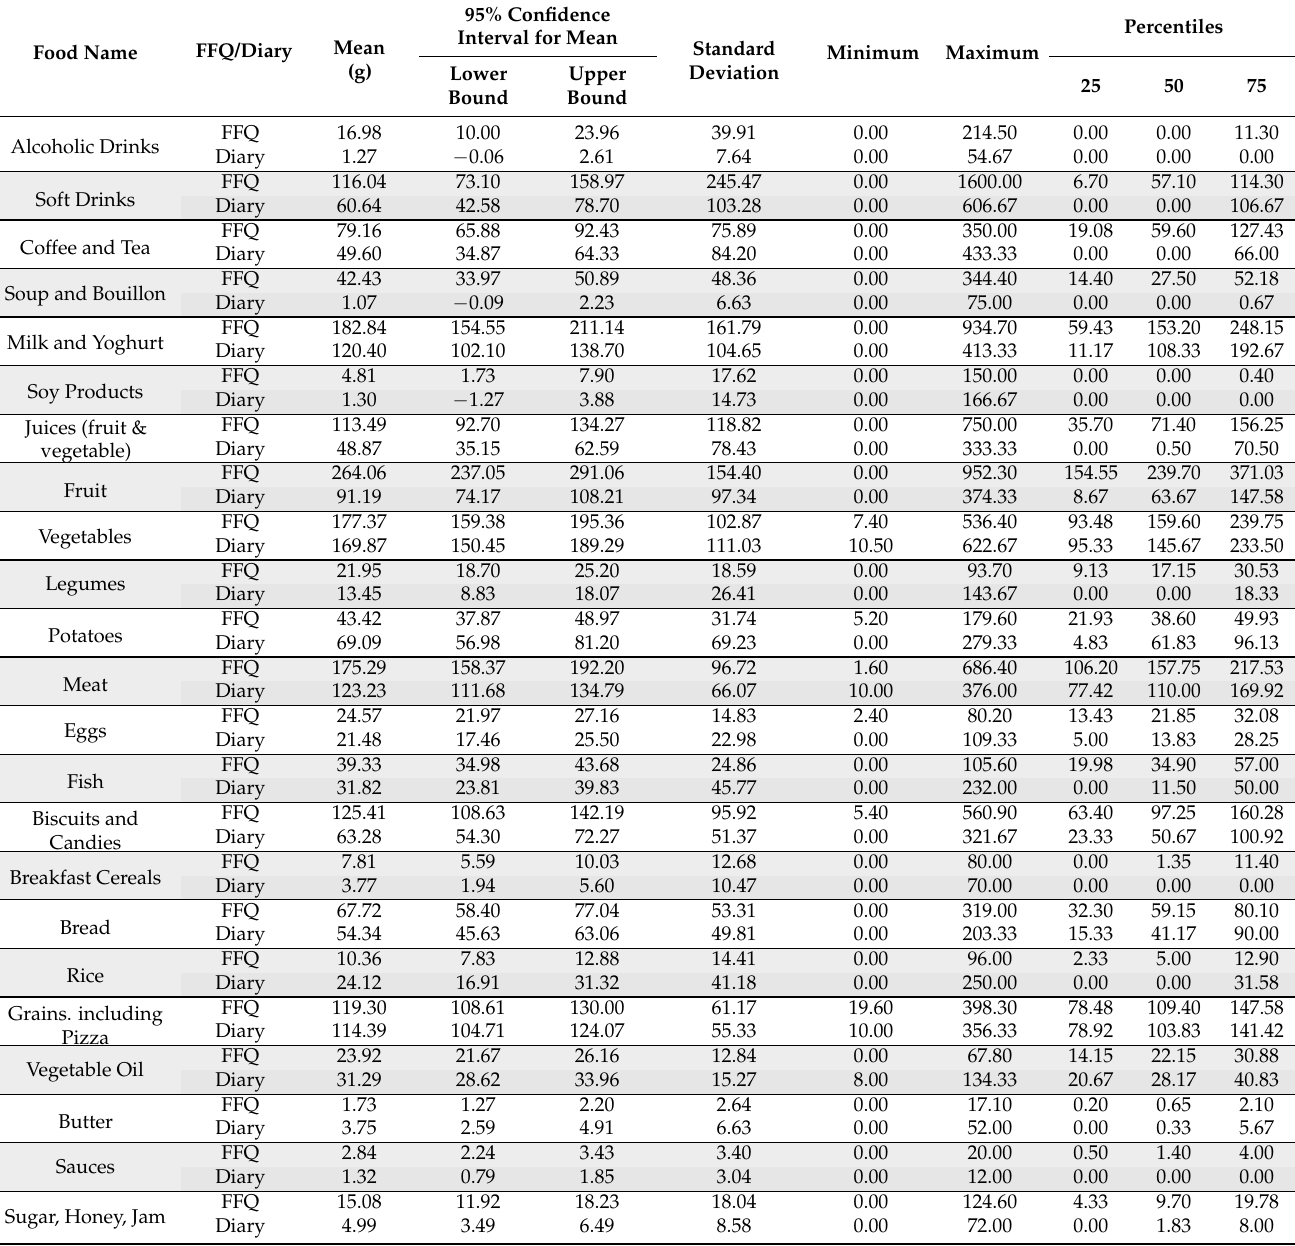
Table A2. Descriptive of the total study population (mean ± standard deviation; Min, P25, P50, P75 and Max; 95% confidence interval). Descriptive females; n = 128.